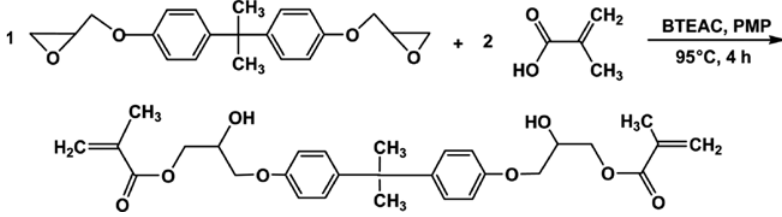
Figure 2: Preparation of epoxyacrylate.